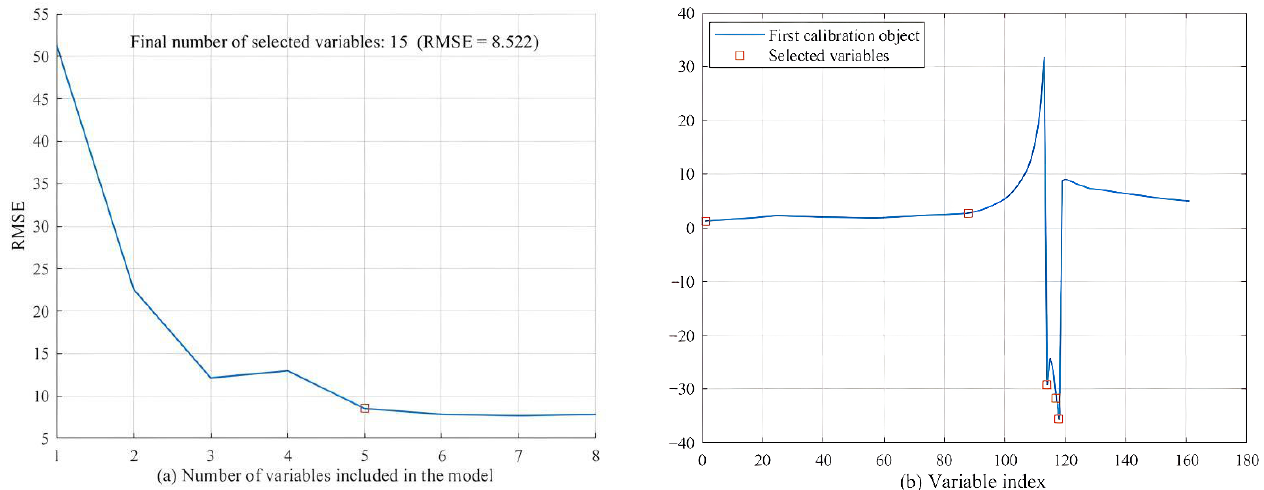
Figure 6. Effective wavelength selection by SPA: ( a ) the RMSE change with wavelength (variable) number in the model; ( b ) the variable index of selected five effective wavelengths.